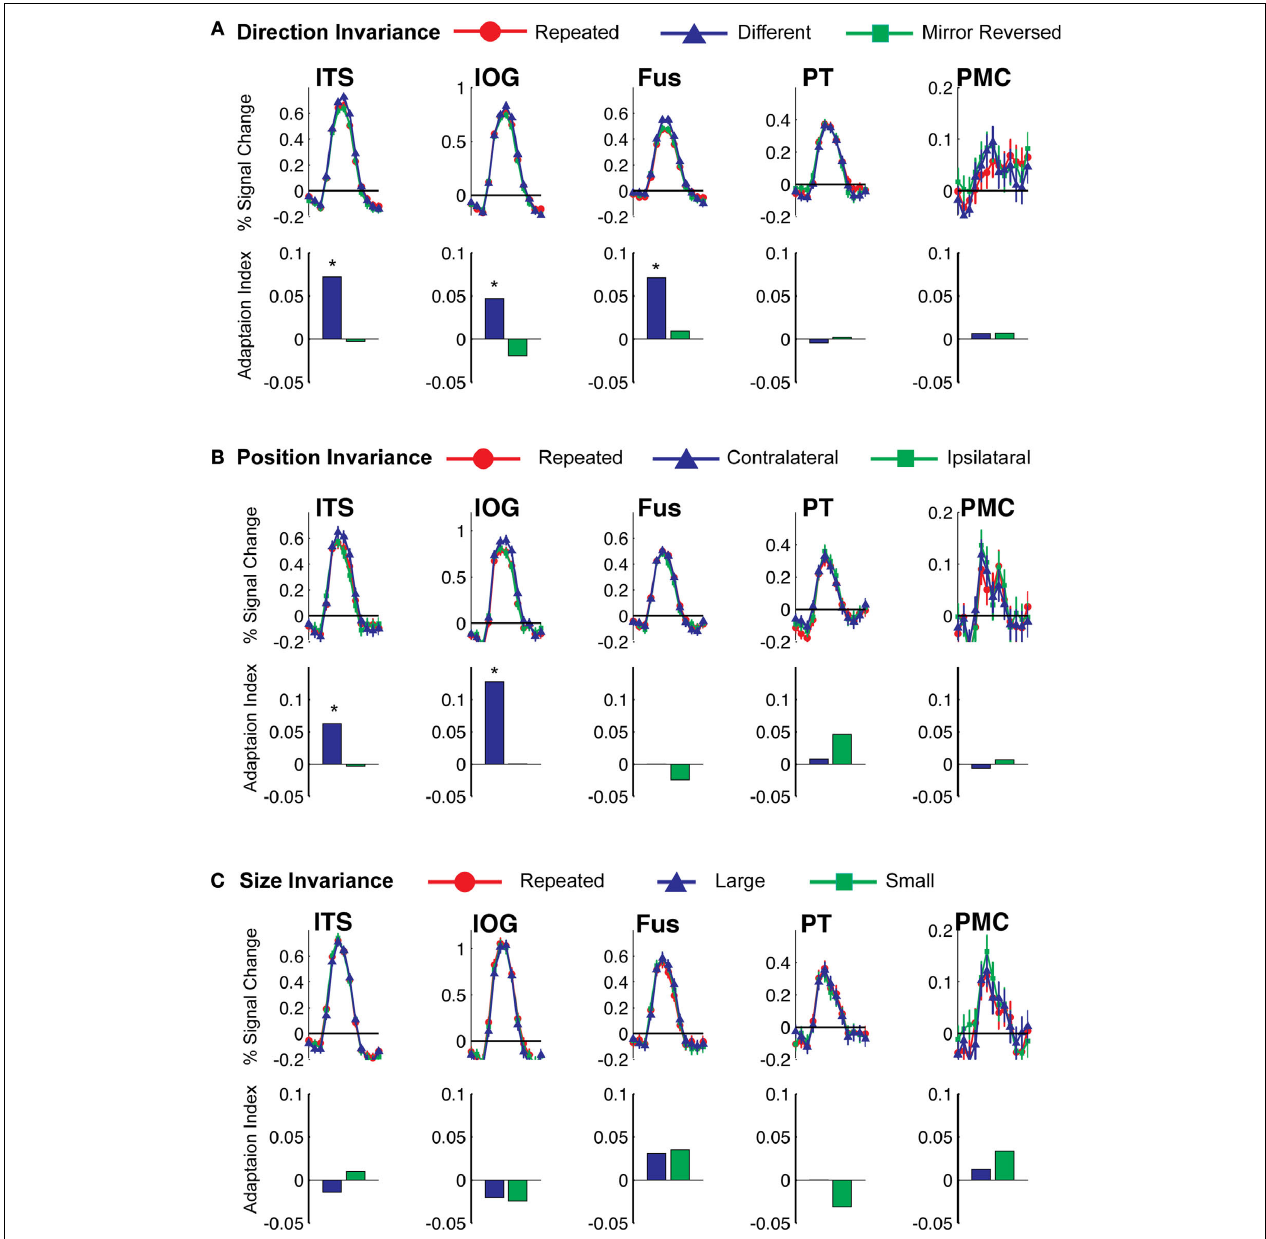
FIGURE 6 | Average deconvolved hemodynamic response functions and the corresponding adaptation indices for each of the remaining ROIs. (A) Experiment 1, action specifi city and invariance across mirror reversals, (B)